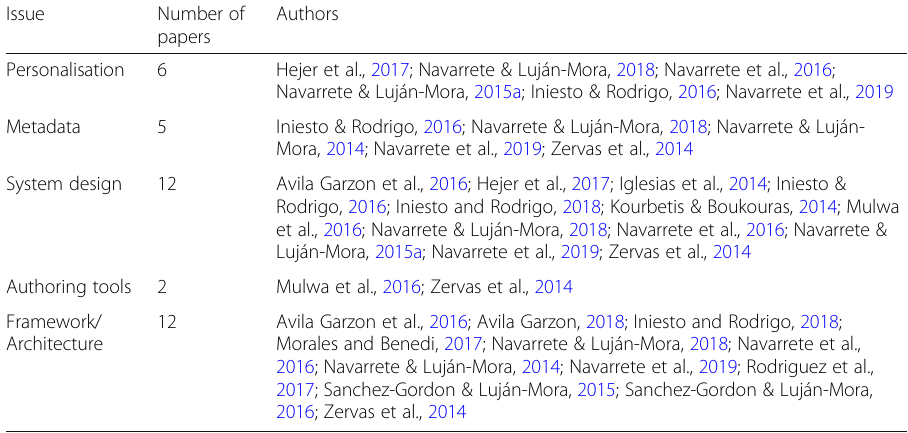
Table 4 Issues investigated during the use of open educational resources and practices for accessible